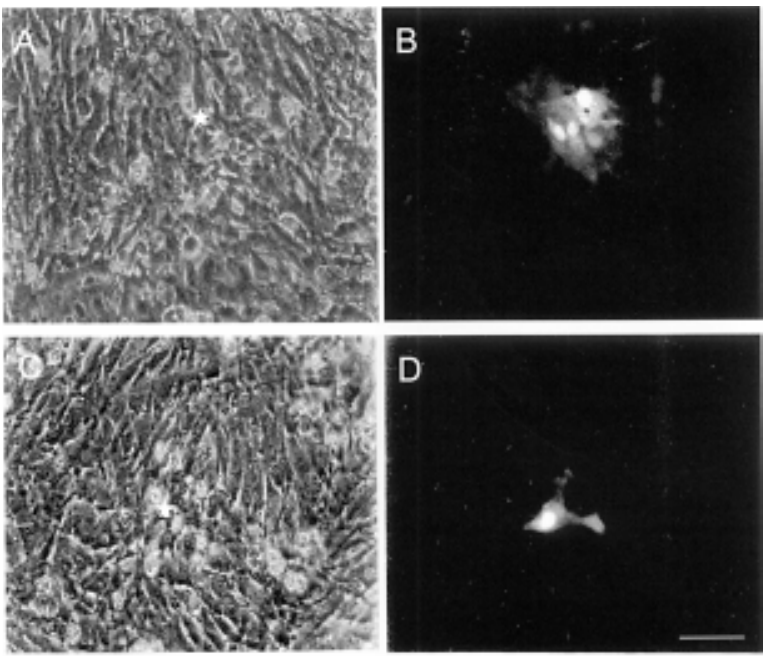
Figure 5 - Photomicrographs of primary cultures of neonatal mouse cardiomyocytes under phase contrast (left panels), and fluorescence (right panels). In the control culture (A and B), the dye spread to 4 cells adjacent to the injected cell. In the culture treated with serum that showed adrenergic-like effects on heart rate (in the isolated whole rabbit heart), the dye remained restricted to the injected cell (C and D). Calibration bar in D holds for all micro- graphs and indicates 50